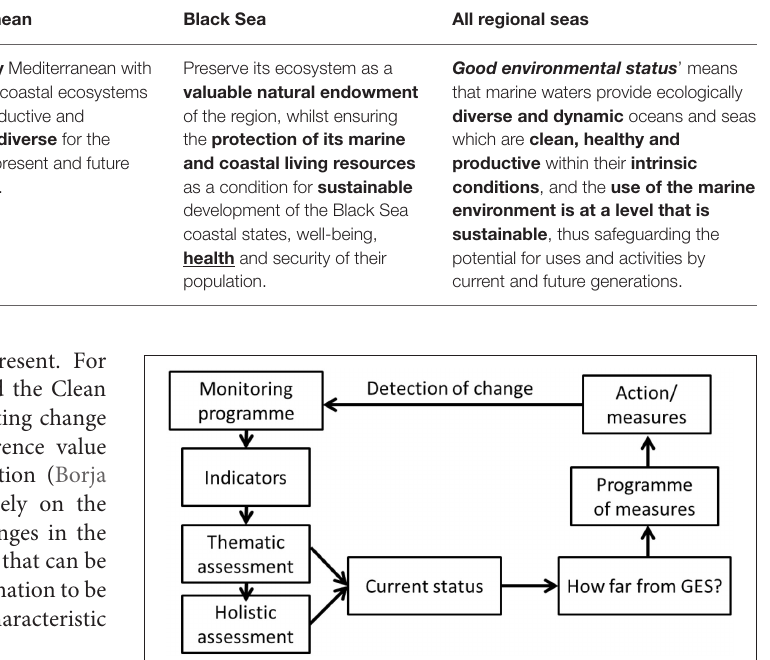
FIGURE 9 | The overall cycle for the assessment of the marine ecosystem status that links marine monitoring, indicators, thematic assessments, holistic assessment, and programme of measures in order to detect changes in the status of the marine ecosystems and to assess how far the current status is from the Marine Strategy Framework Directive’s Good Environmental Status